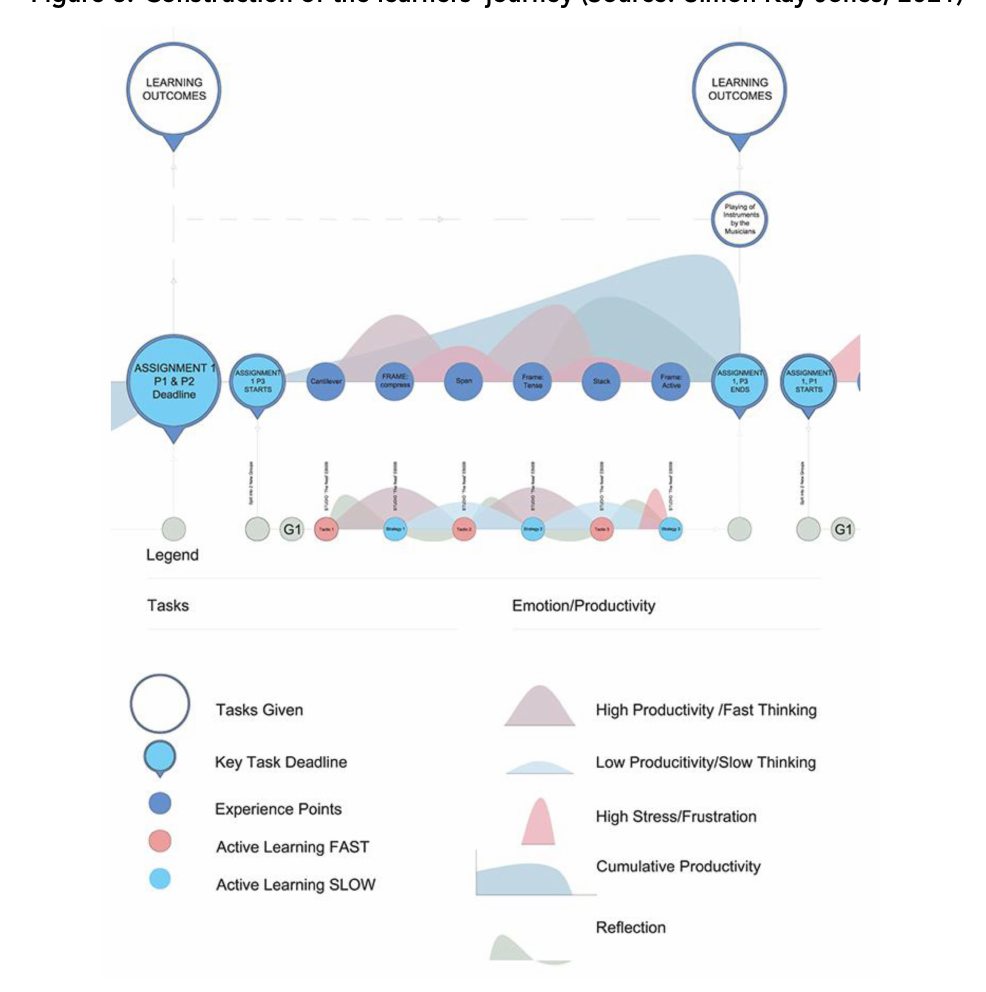
Figure 6. Construction of the learners’ journey (Source: Simon Kay-Jones,